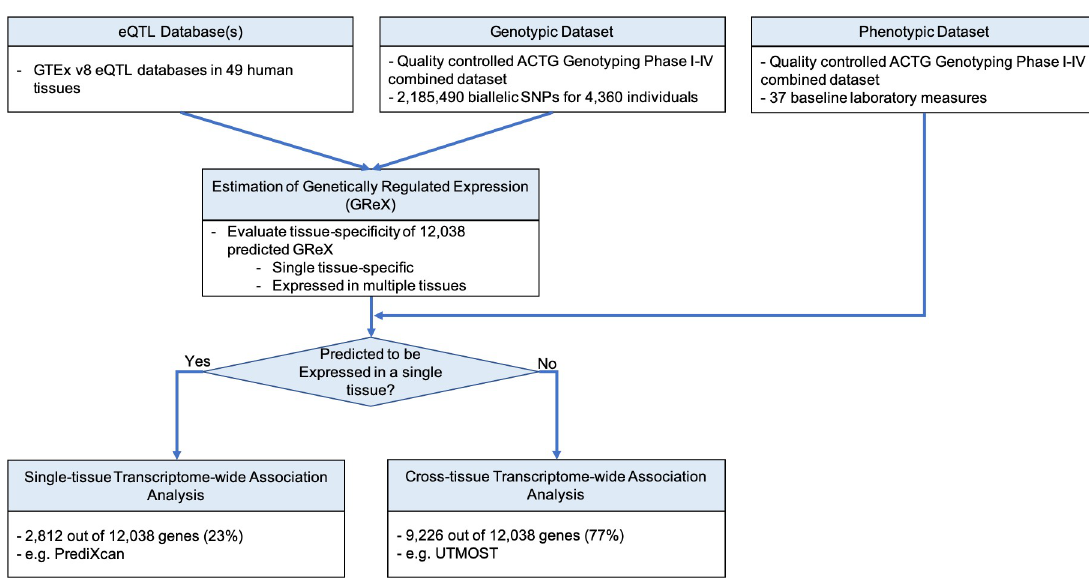
Fig 7. The TSA-TWAS analytic framework for the ACTG combined genotyping phase I-IV baseline laboratory traits. Approximately 2.2 million SNPs, 4,360 individuals, and 37 baseline laboratory traits survived the QC. UTMOST eQTL models were used to impute GReX of a total of 12,038 genes in 49 tissues. 2,812 genes (23%) had GReX in one single tissue, and 9,226 genes (77%) had GReX in more than one tissue.